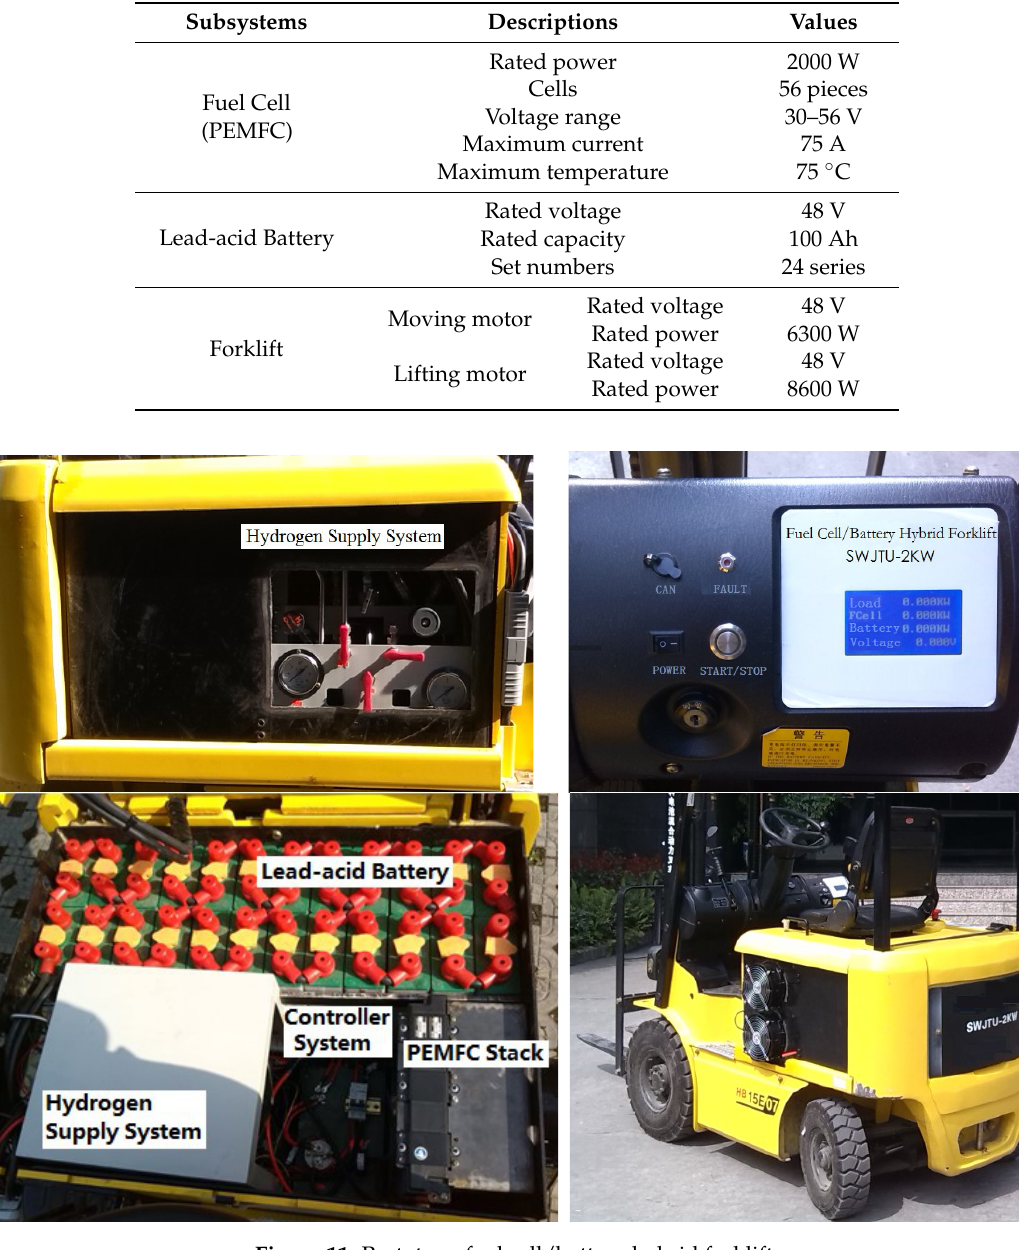
Figure 11. Prototype fuel cell/battery hybrid forklift.